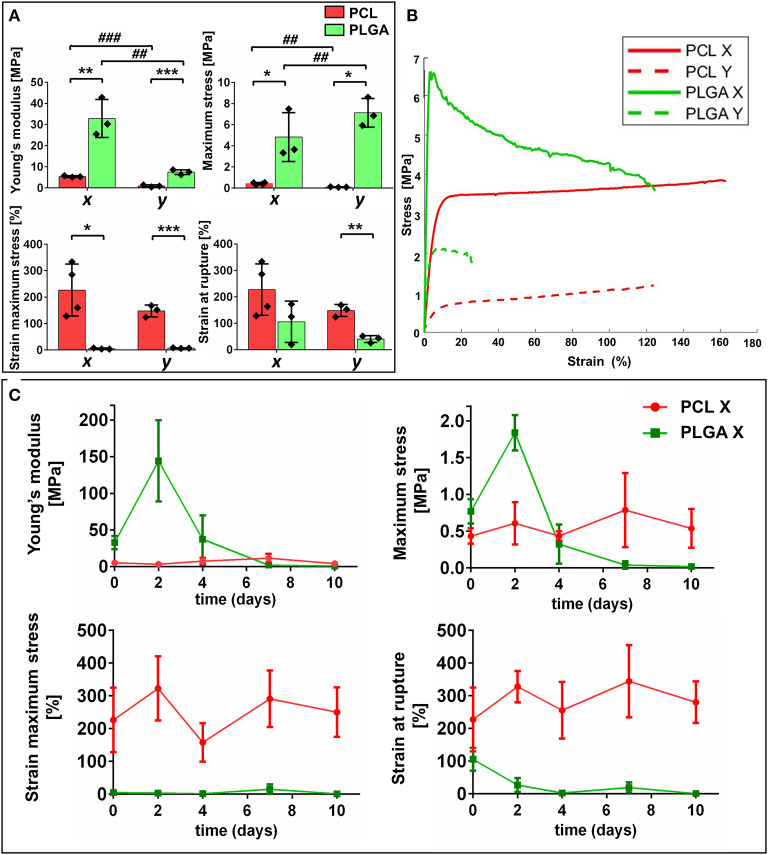
Mechanical characterization of the scaffolds. (A) Bar graphs summarize results of mechanical tests on poly(ε-caprolactone) (PCL) and polylactic-co-glycolic acid (PLGA) structures namely: Young's modulus, maximum stress, strain at maximum stress and strain at rupture. Values are means ± SD, N = 3 biological replicates, each one with 3 technical replicates. *P < 0.05, **P < 0.01, ***P < 0.001, vs. PCL-scaffold within same direction of testing [(x) or (y)]; ##P < 0.01, ###P < 0.001 vs. the (x) direction of the corresponding group (PCL or PLGA). (B) Stress–strain curves of synthetic structures (PCL and PLGA) in both directions (x and y). (C) Graphs showing mechanical features of PCL and PLGA scaffolds at different timepoints.